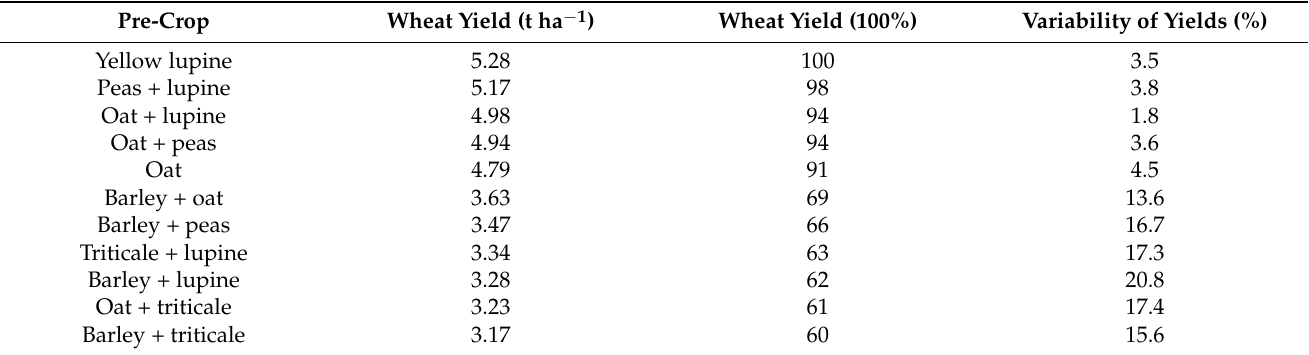
Table 1. Yields of winter wheat depending on the pre-crop type